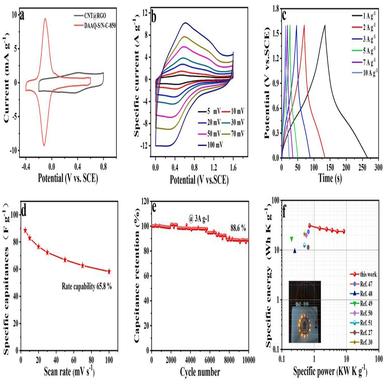
(a) CV curves of the positive and negative materials in a three-electrode call setup. (b) CV curves at diverse scan rates from 5 to 100 mV s − 1 and (c) GCD profiles at different current densities from 1 to 10 A g− 1 of DAAQ-S/N-C-850//CNT@RGO ASC. (d) Specific capacitance retention of ASC at varied scan rates from 5 to 100 mV s − 1 . (e) Capacitance retention with 10,000 cycles at a current density of 3 A g− 1 . (f) specific power versus specific energy Ragone diagram compared with other biomass-based supe